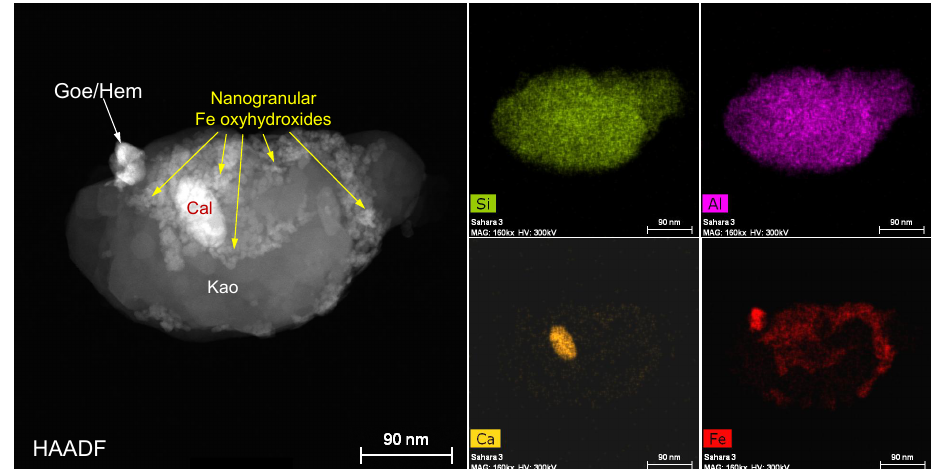
Figure 8. STEM/HAADF photomicrograph and corresponding EDX elemental maps of a kaolinite (Kao) particle internally mixed with a nearly rhombohedral-shaped goethite or hematite (Goe/Hem) crystal, a calcite (Cal) particle, and aggregates of Fe-rich nanoparticles (nanogranular Fe oxyhydroxides), likely